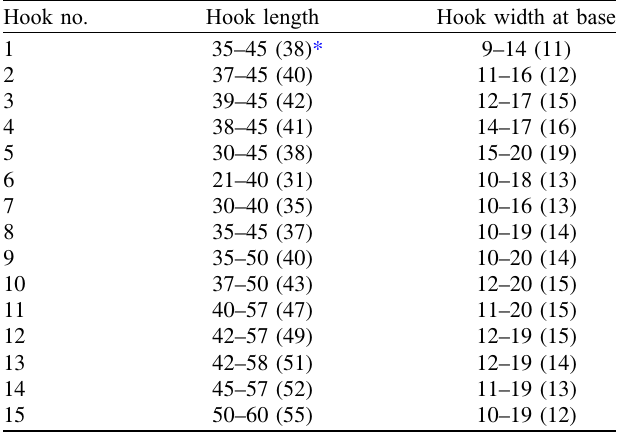
Table 2. The size of 15 hooks in one longitudinal row on the proboscides of 10 cystacanths of Pro fi licollis altmani from Emerita analoga in